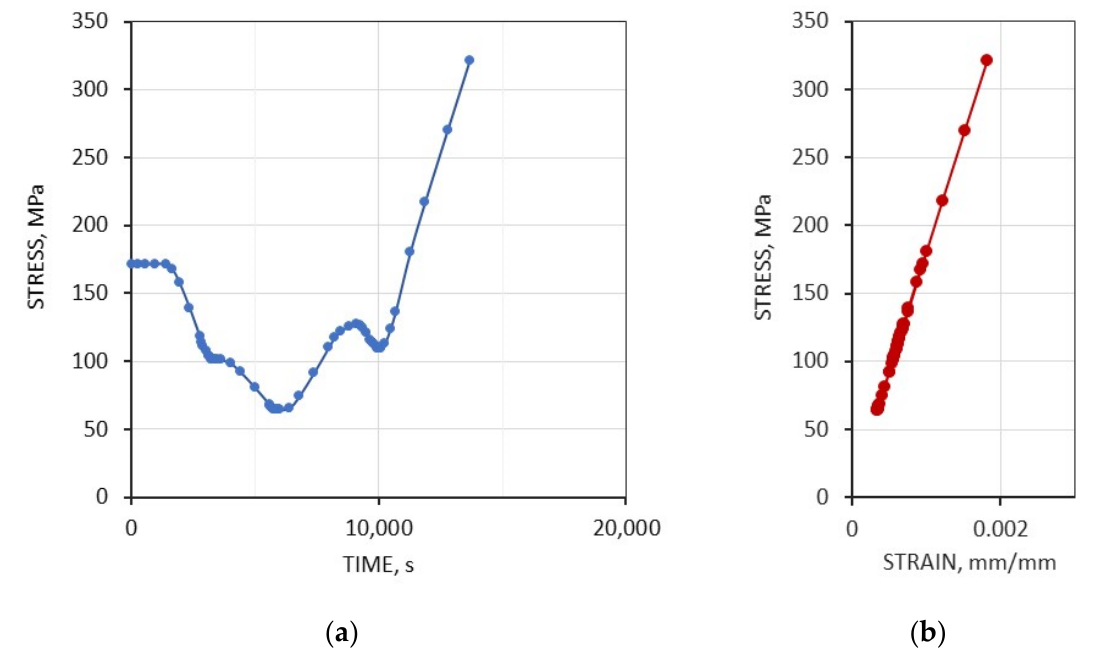
Figure 11. The ( a ) stress versus time and ( b ) stress versus strain relationships in the OR HOT startup scenario under industrial operating conditions.